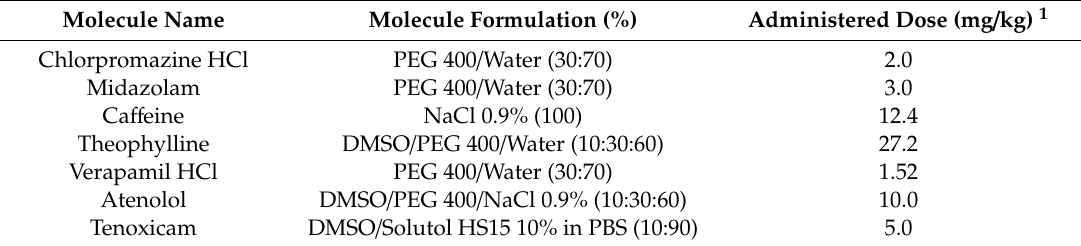
Table 4. Drug formulation (in vivo and in vitro) and dosage (in vivo) used for the permeability